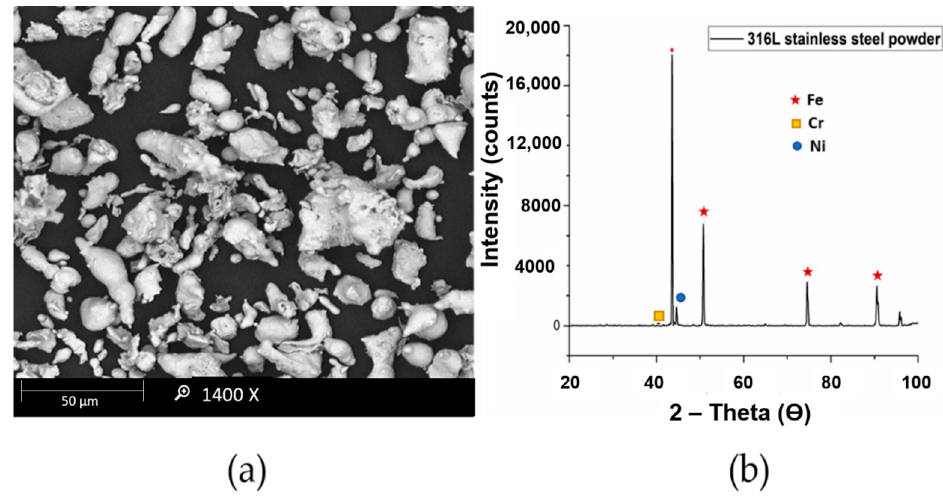
Figure 1. ( a ) SEM ( b ) XRD analysis of 316L stainless steel powder.